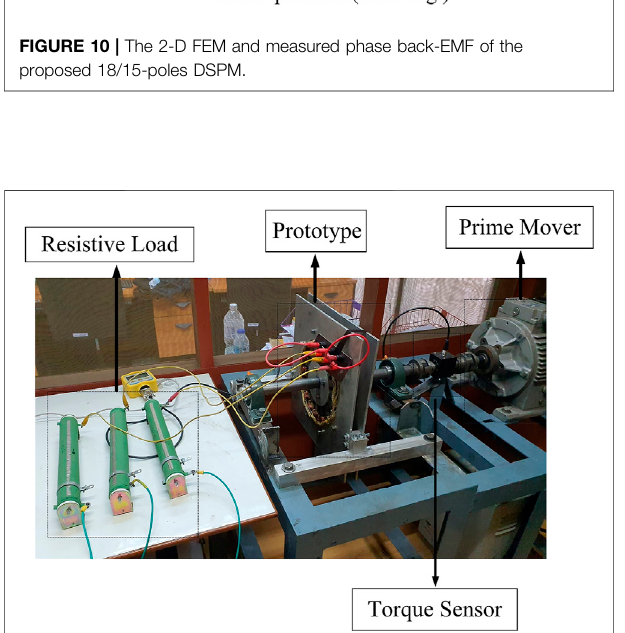
FIGURE 11 | Experimental setup of the 18/15-poles DSPM prototype machine.